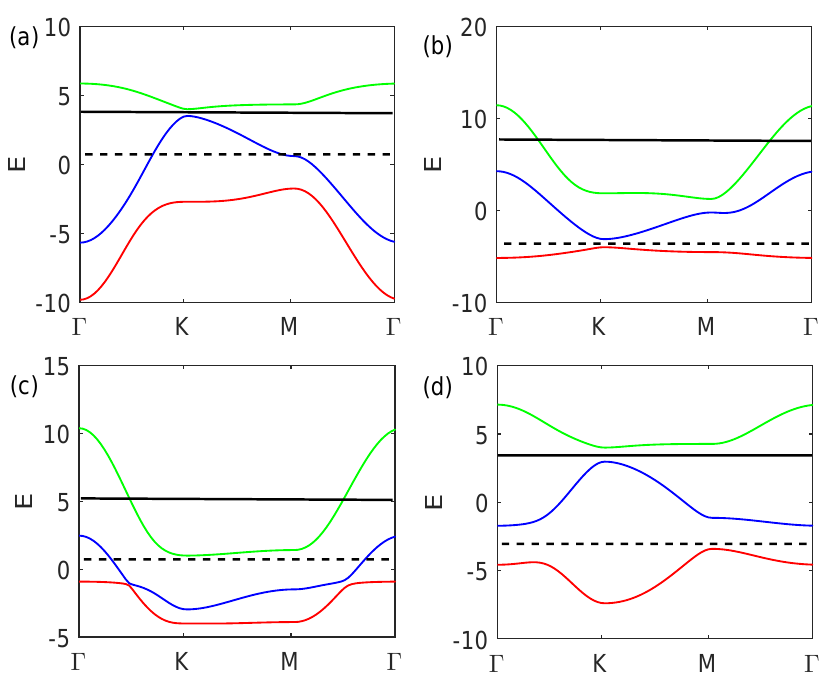
Figure 3. Dispersions of the Λ / V -type dice model along the high-symmetry path Γ -K-M- Γ . ( a ) ∆ a = 2, φ a = 2.5, ( b ) ∆ b = 2, φ b = 0.5, ( c ) ∆ c = − − and green solid lines show the dispersions. The lower Fermi energy (black dashed line) and higher Fermi energy (black solid line) show the cases of 1/3 and 2/3 filling,